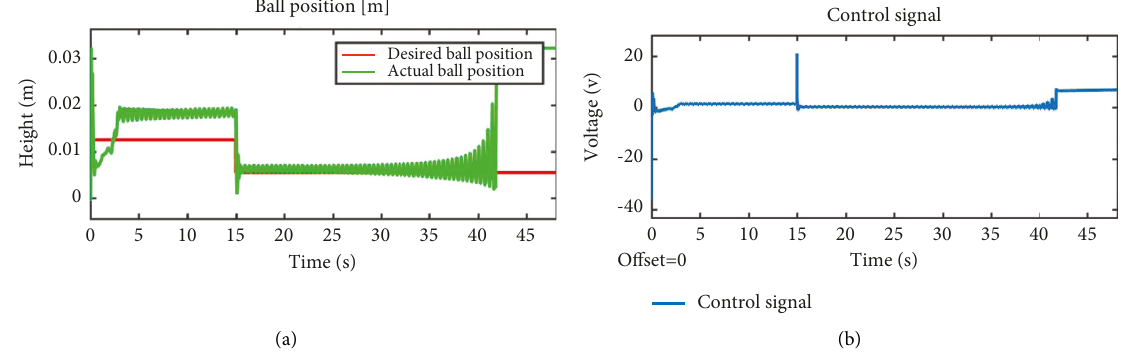
Figure 3: STEP output and control signal for the PID controller.